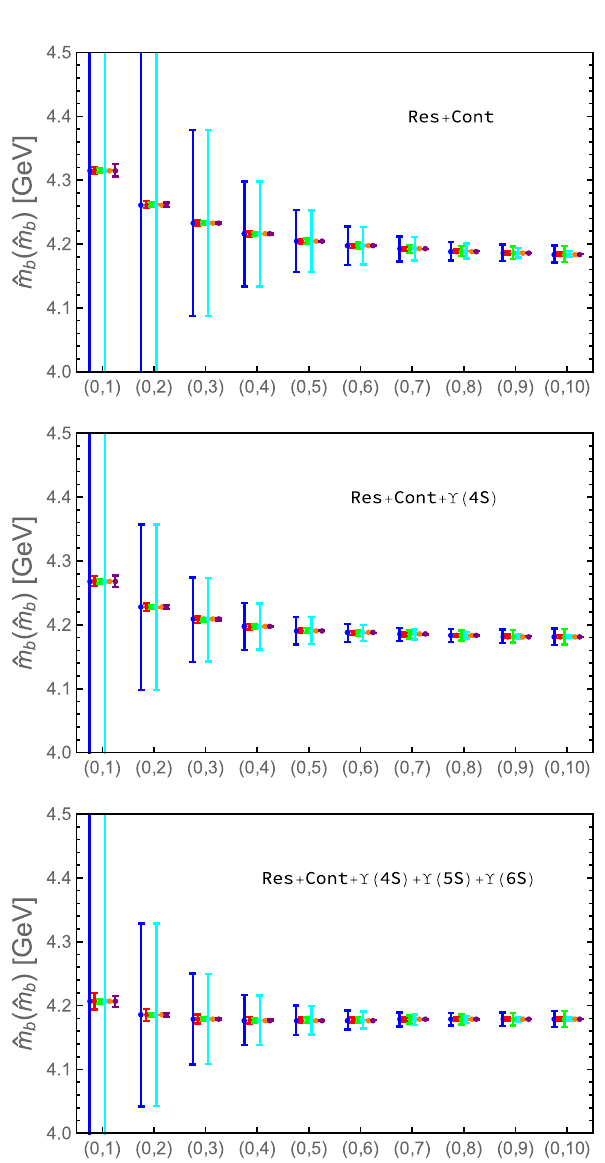
Fig. 4 Same as in Fig. 3 but including only the resonances below threshold (top), with the ansatz modified to include the ϒ( 4 S ) as a (cid:9) - function (middle), and with the ansatz modified to include the ϒ( 4 S ) , ϒ( 5 S ) and ϒ( 6 S ) as (cid:9) -functions